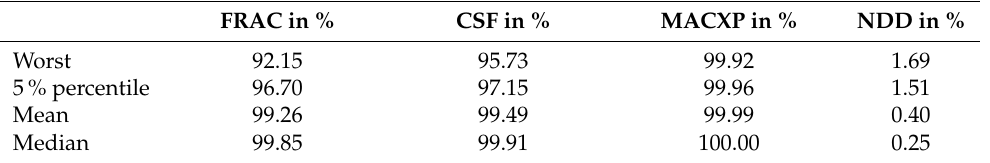
Figure 9. Identified and reference FRFs in the x -direction from force to displacement at the WPT at the validation position z 1 = 294mm for the case “disturbed model vs. simulated data”; for better − readability, the highlighted section has a linear amplitude scale in contrast to the main plot. Addi- tionally, a model FRF is shown where the identified damping deviations were permuted randomly, emphasizing the need for properly identified damping parameters. Table 4. Statistics of model performance indicators using the identified stiffness and damping parameters for the case “model vs. disturbed model” for three considered axis positions z 2 , z 3 , and z 4